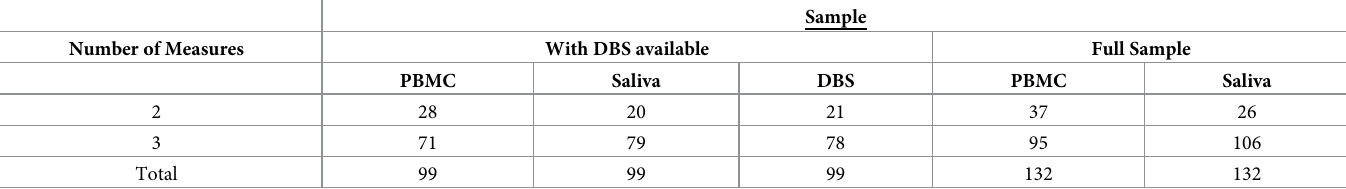
Table 2. Number of valid TL measures by specimen Type.